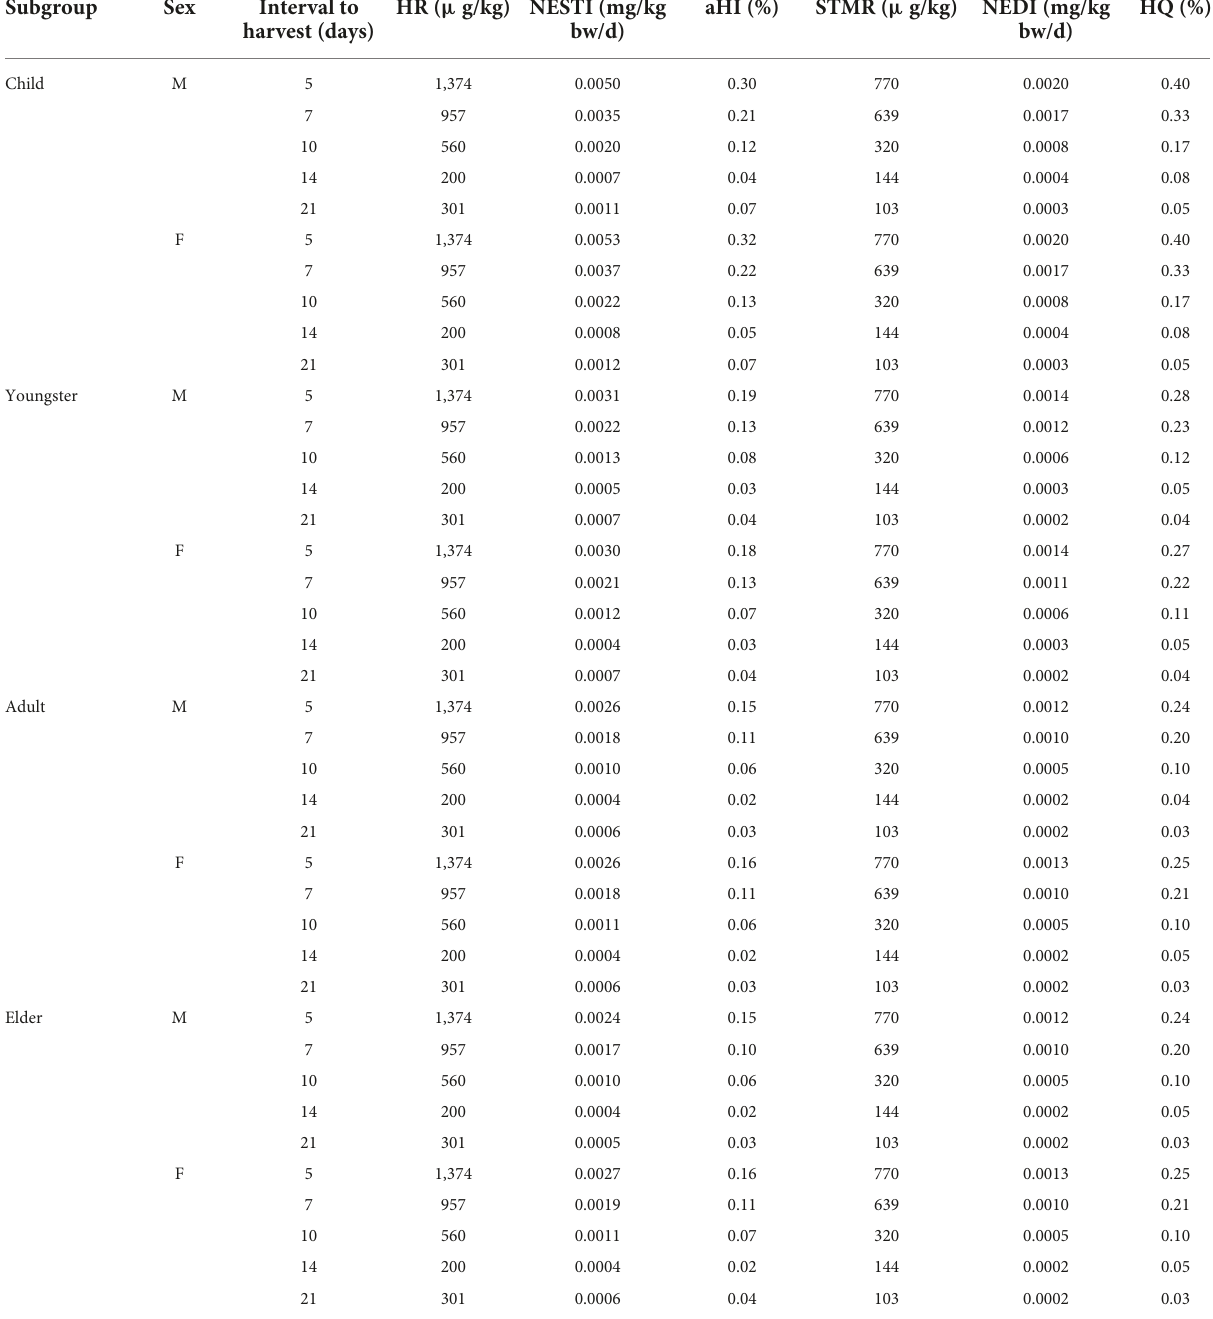
TABLE 1 The acute and chronic dietary risk assessment of tristyrylphenol ethoxylates (TSPEOn) in cowpea.